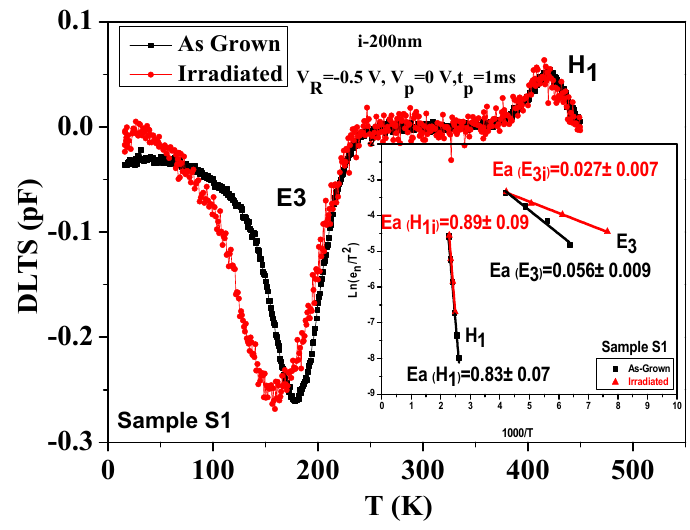
Figure 6. A typical capacitance DLTS spectrum recorded for both as-grown and irradiated sample S1 with the following parameters: V R = − 0.5 V, V P = 0 V and the duration of the filling pulse was t p = 1ms at rate window 500 s − 1 . The inset demonstrates the Arrhenius plots for the detected level H 1 , H 1i , E 3 and E 3i